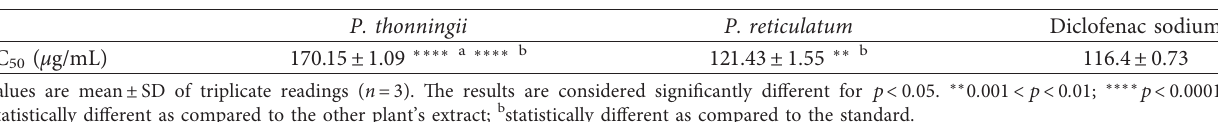
Figure 4: Effect of P. reticulatum and P. thonningii leaves extracts on heat-induced albumin denaturation in comparison with diclofenac sodium activity. P. thonningii inhibition ability is significantly low ( p < 0 . 05). Table 4: Albumin denaturation inhibition IC50 values of the two plants’ extracts and diclofenac